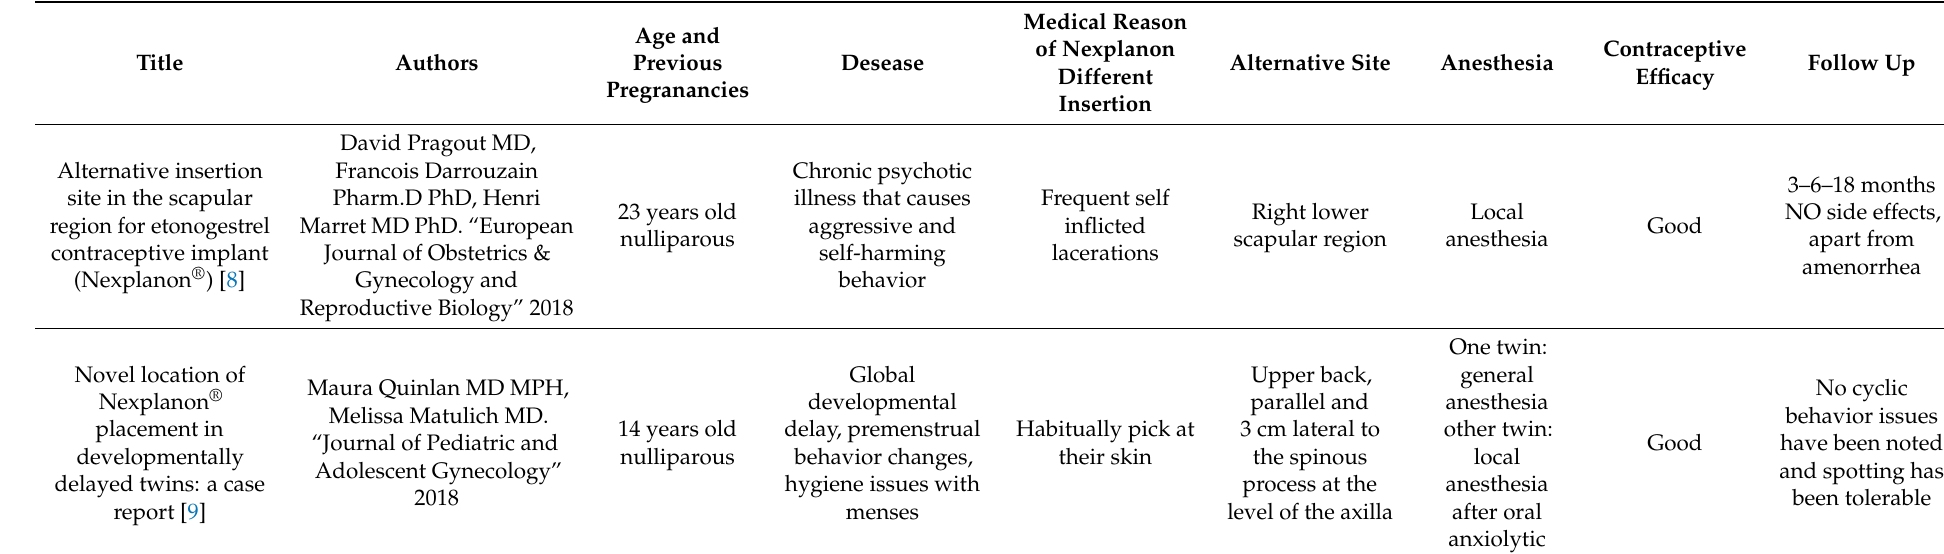
Table 1. Review of the